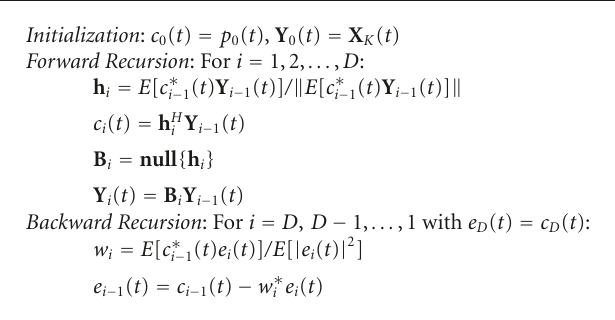
Algorithm 1: MWF algorithm [21].